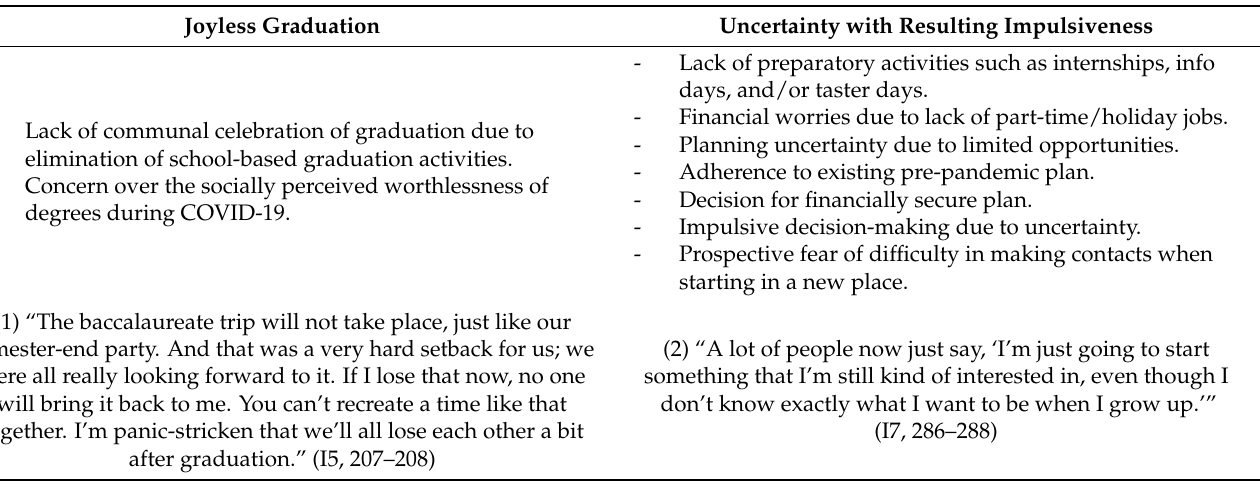
Table 3. Inductive coding: findings on the area of